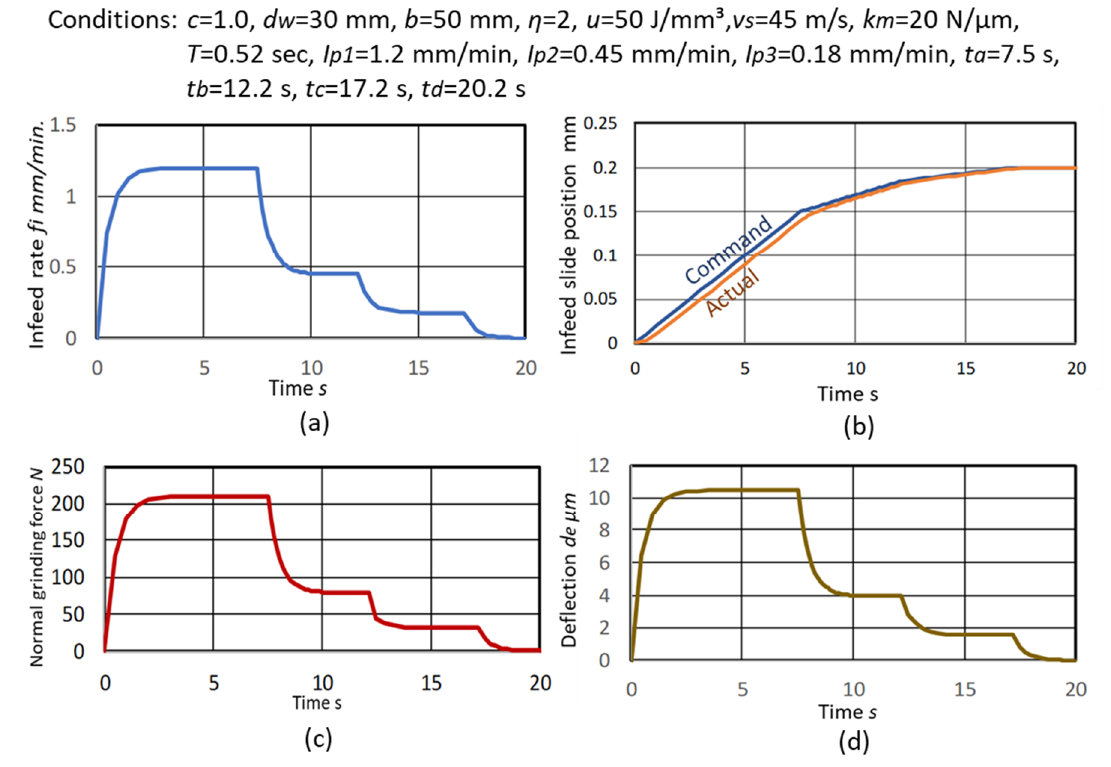
Figure 15. Process parameters during the infeed grinding cycle. ( a ) Infeed rate; ( b ) Command and actual slide position; ( c ) Normal grinding force; ( d ) Deflection of grinding machine.